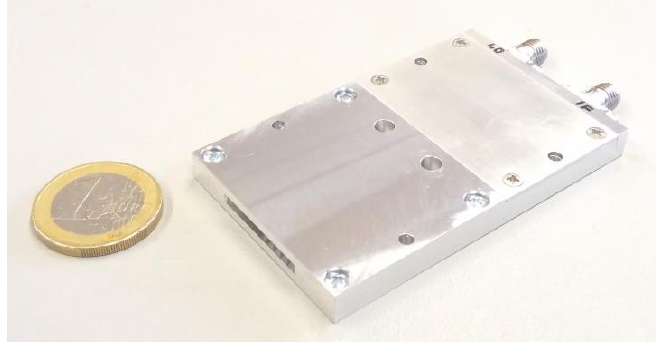
Figure 15. Fabricated mmW down- and up-converter containing a built-in 14 dB horn antenna, MMIC balanced mixer, planar filters and LO and IF connectors.